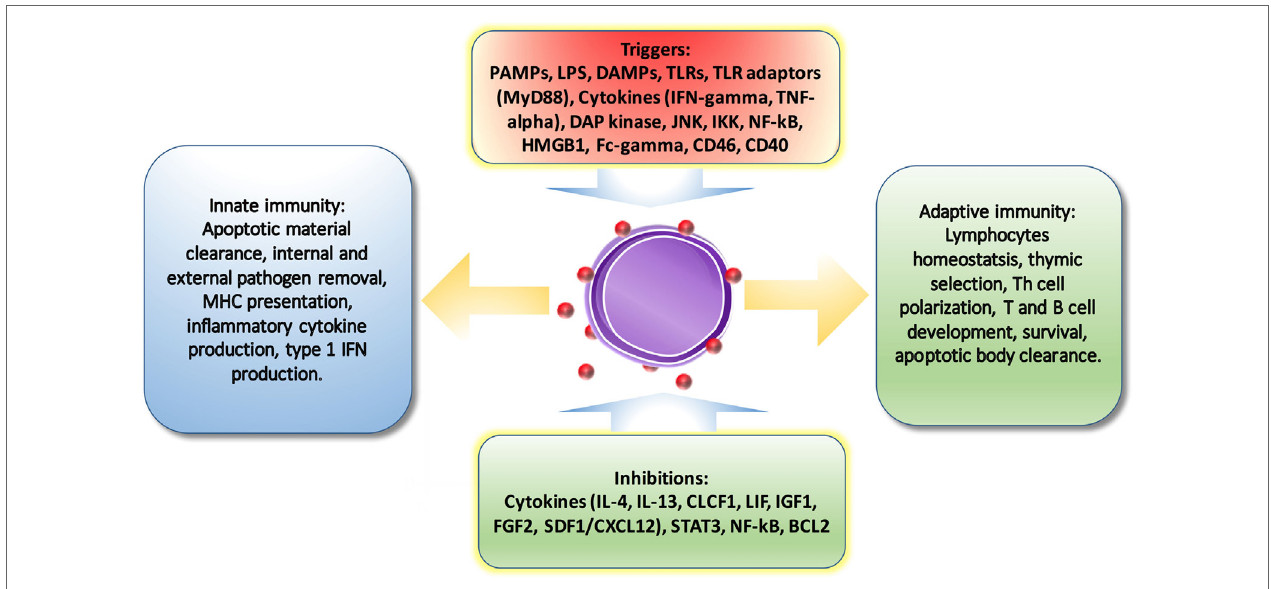
FigURe 3 | The regulations of autophagy on immune system. Autophagy is triggered and inhibited by cytokines and molecules from immune system. And also, autophagy is involved in pathogen removal, cytokine secretion, lymphocyte survival and differentiation, MHC presentation, apoptotic cell clearance, and pro­inflammatory